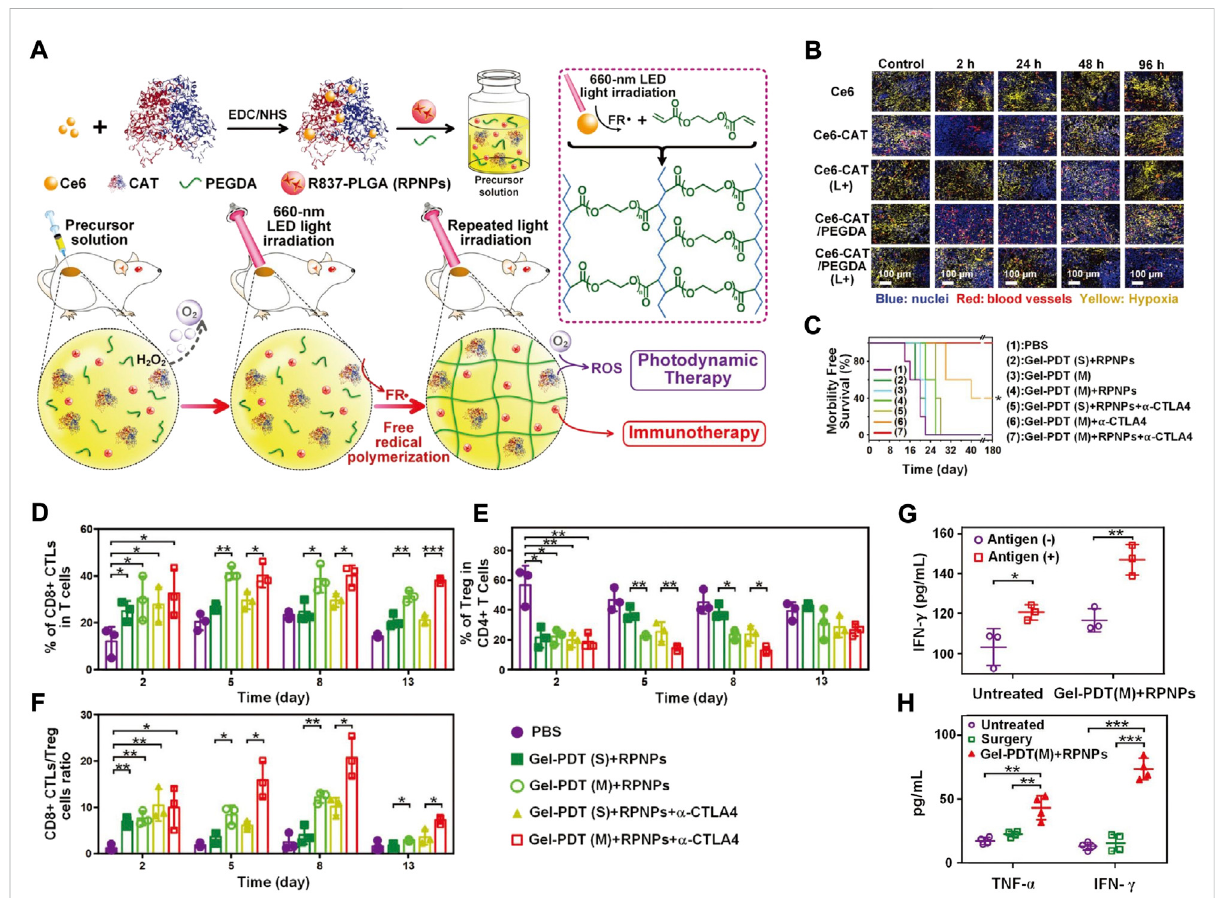
FIGURE 8 (A) Schematic illustration of the light-triggered fabrication of Ce6-CAT/PEGDA hydrogel in tumor sites. (B) Immuno fl uorescence analysis of tumor sections stained with anti-pimonidazole antibody (yellow) and anti-CD31 antibody (red). TUNEL (C) Morbidity free survival of the tumor-bearing mice after indicatedtreatments( n =7). (D – F) Proportionsoftumor-in fi ltratingCD8 + CTLs (D) ;Tregcells (E) andCD8 + CTLs/Tregcells (F) afterindicatedtreatments( n = 3). (G) ThesecretionofIFN- γ fromrestimulatedsplenocytesbytheadditionofthedeadcell(antigen) invitro ( n =3). (H) Serouscytokine(TNF- ɑ ,IFN- γ ) levelsafterindicatedtreatments( n =4).Statisticalanalysiswasperformed via one-wayANOVAusingtheTukeypost-test. p < 0.05;**, p < 0.01;***, p <